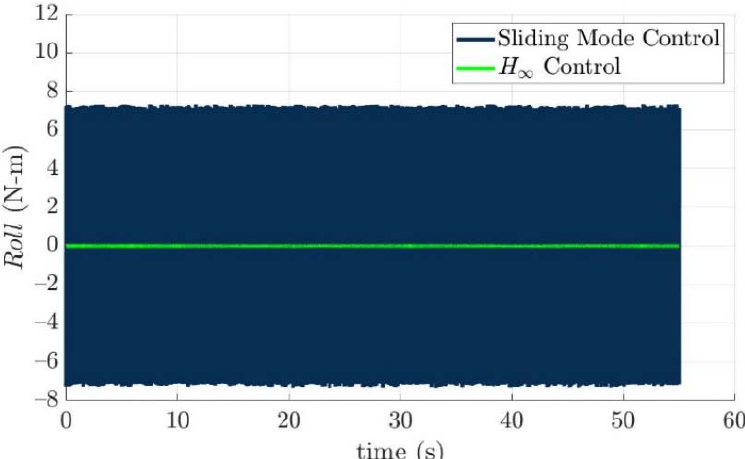
Figure 17. Heave forces of the developed torpedo-like underwater vehicle with respect to the sliding mode control law and the nonlinear H ∞ control law.